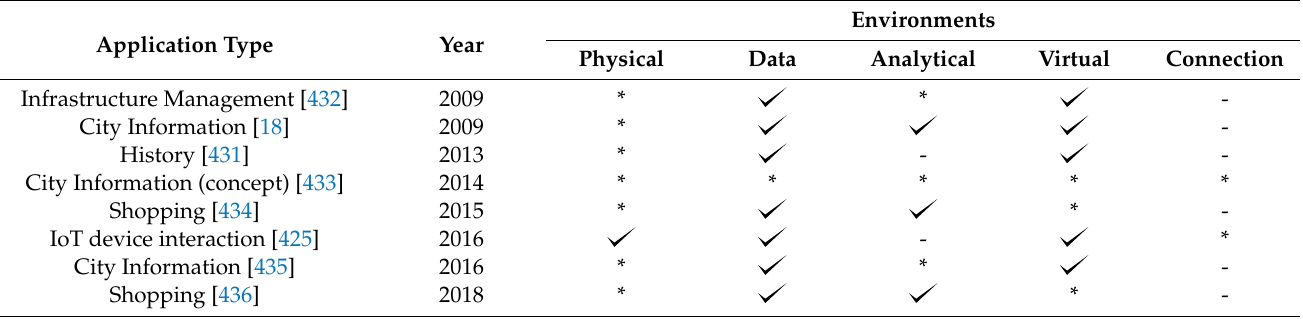
Table 6. Recent and Ongoing Research Applying the Fused Twins